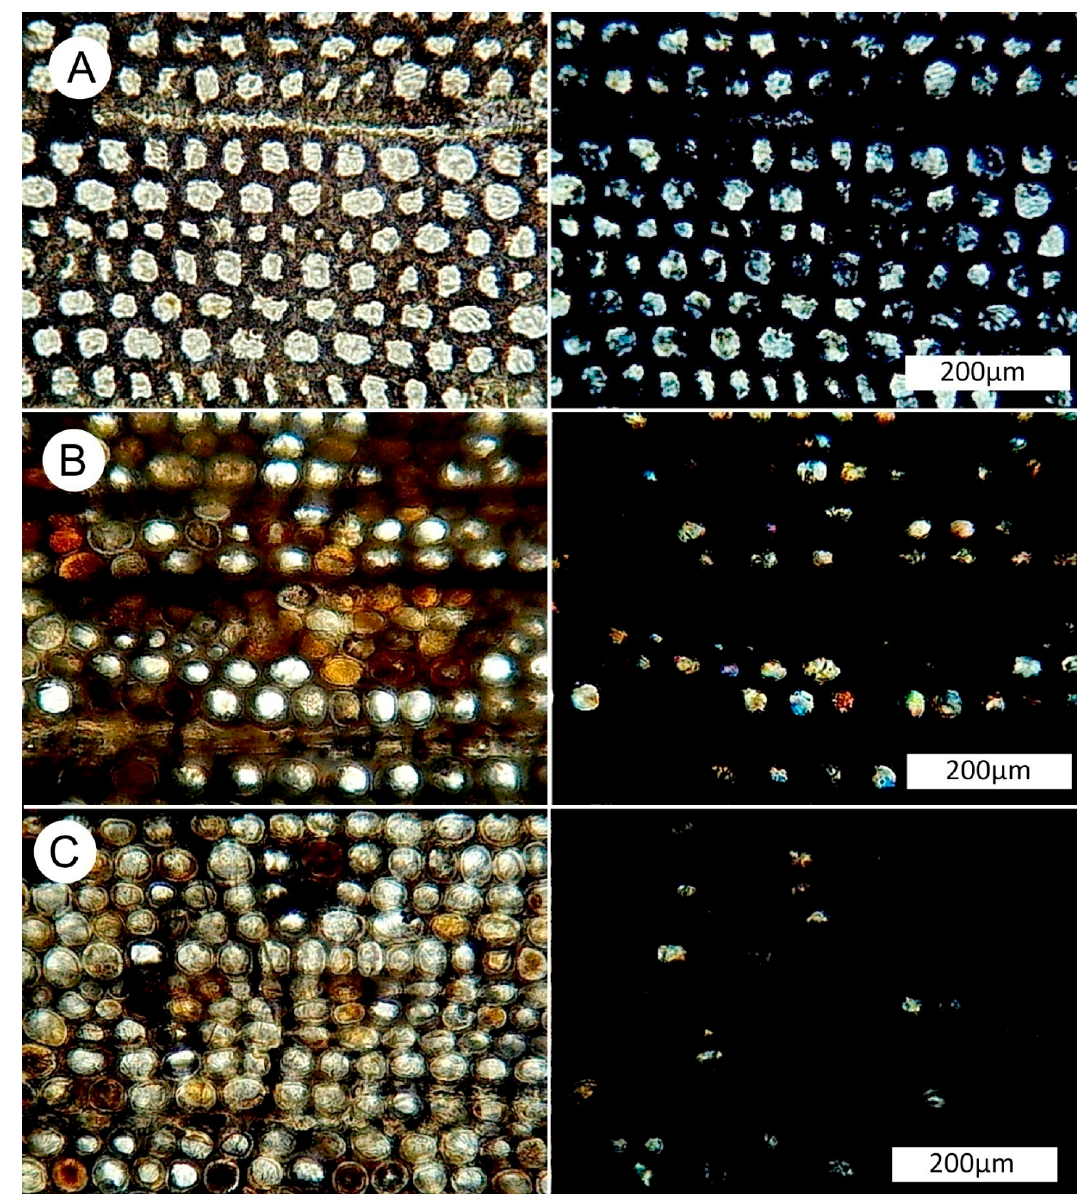
Figure 12. Optical photomicrographs of Las Crucitas sample LC-B. For each photo pair, the image on the left is ordinary transmitted light, and the photo on right is a polarized light view. The opaque black (isotropic) areas in the polarized light images are presumed to consist of amorphous opal (opal-A). The brighter areas are quartz that fills some cell lumina. Transverse views. ( A ) All cell lumina are quartz-filled. ( B , C ) The cells that show brown filling material in ordinary transmitted light are opal-filled, as evidence by their character under polarized illumination. Cells that are colorless in ordinary light are revealed by their interference colors under polarized light.